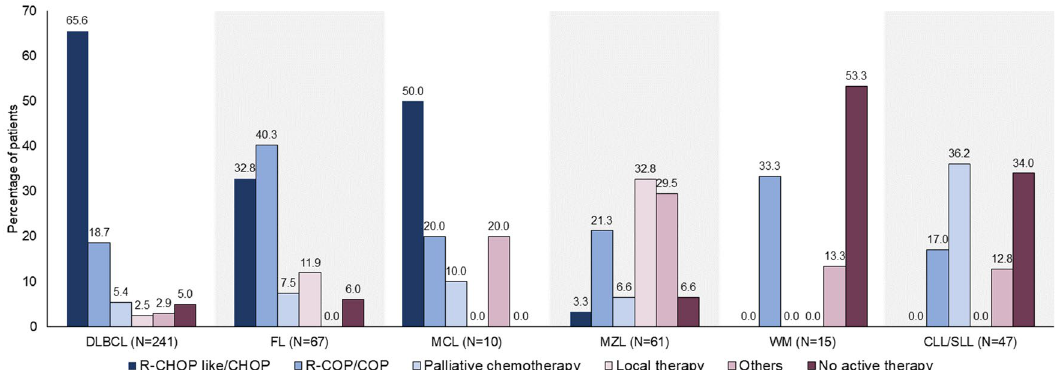
Figure 1. Distribution of the most common 1st-line treatments used in 6 B-NHL subtypes. Note that 1.66% patients received CHOP without R and 2.49% received COP without R. Drug abbreviations are provided in Table